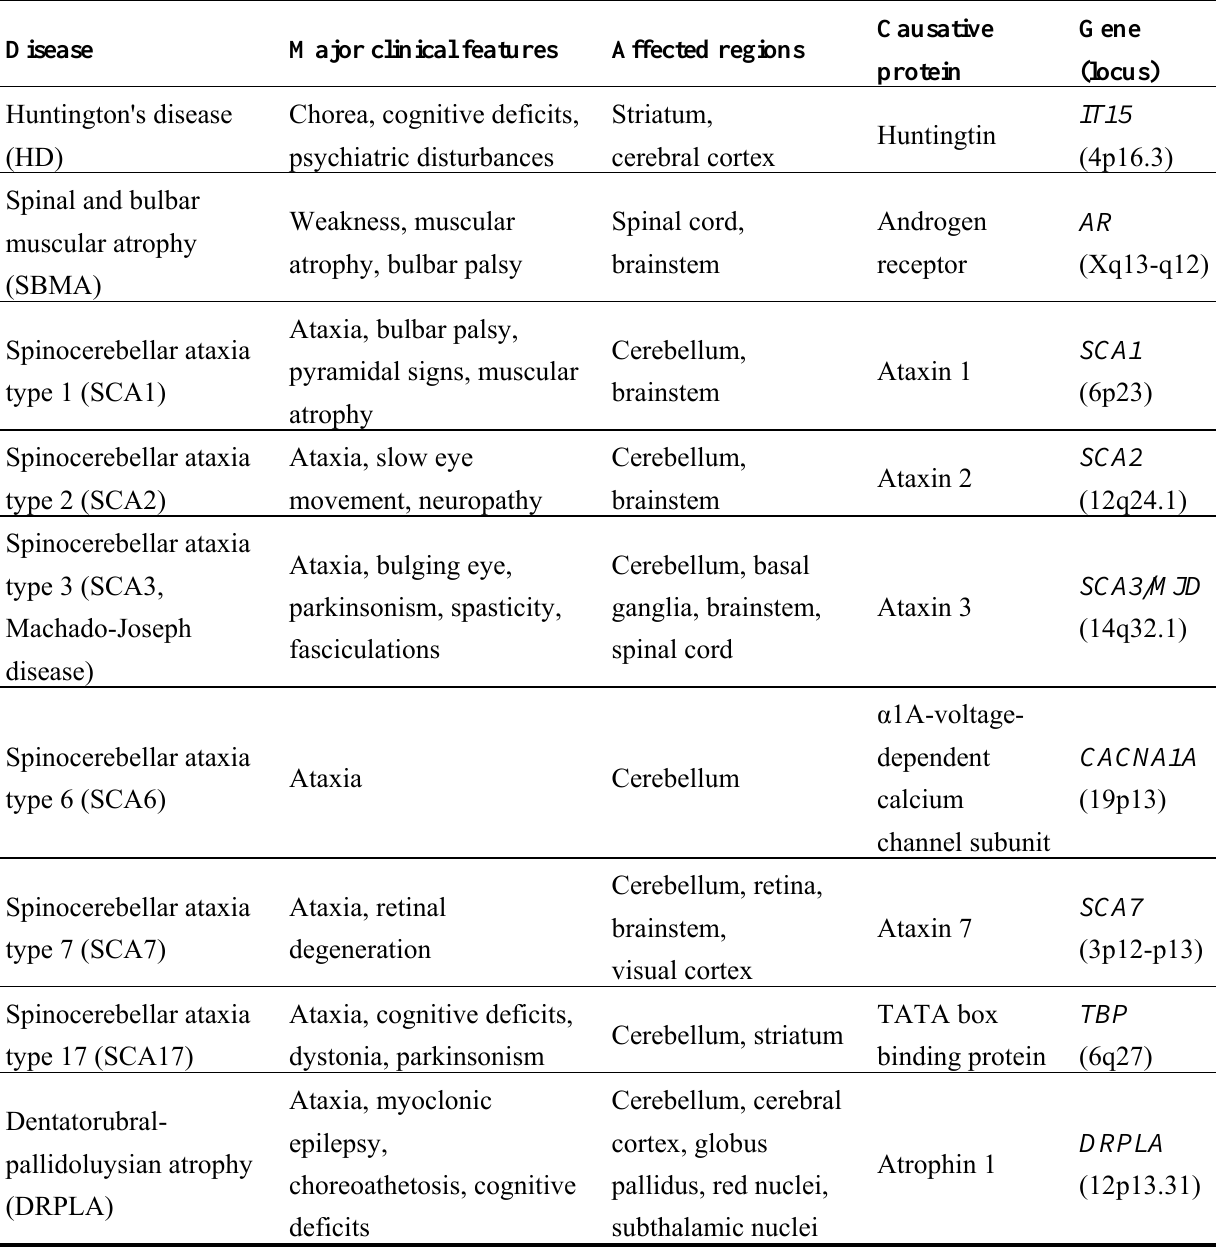
Table 1. Classification of polyglutamine